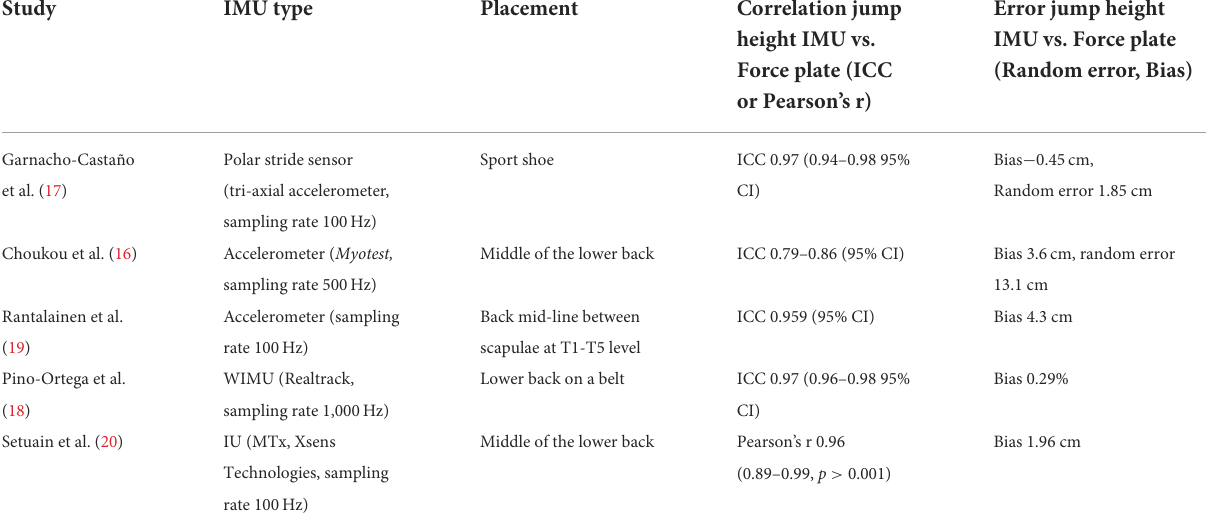
TABLE 4 Overview on studies that validated the measurement of CMJ-height by an IMU-device against CMJ-height calculated from force plate